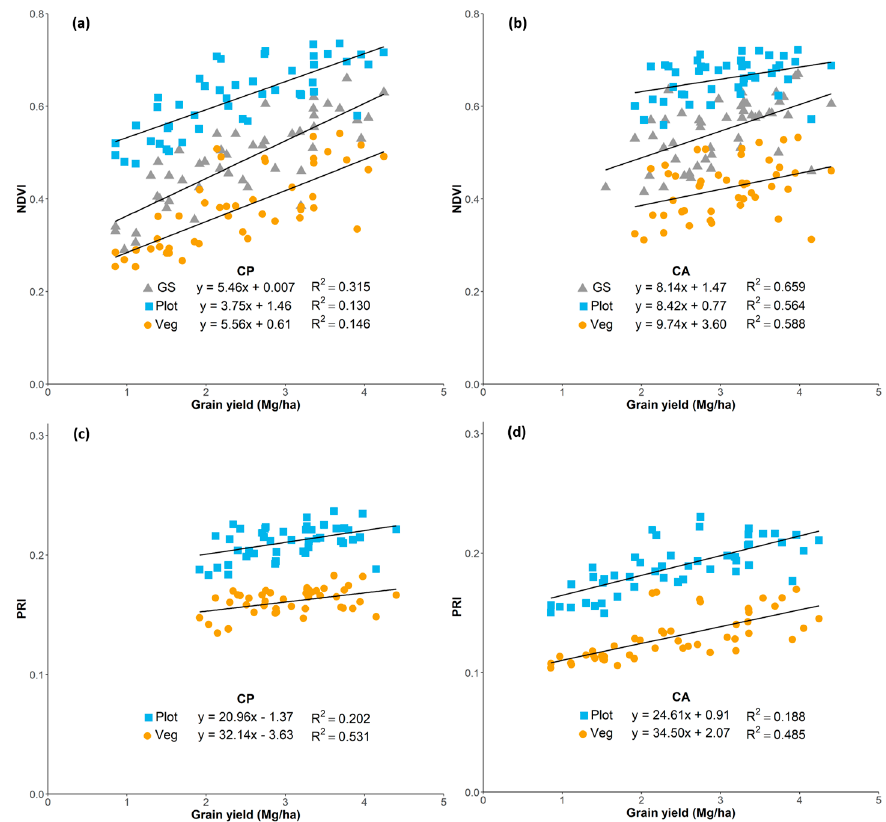
Figure 4. Relationship between grain yield with the Normalized Difference Vegetation Index (NDVI), measured with the GreenSeeker and calculated from the aerial multispectral images ( a , b ) and with the Photochemical Reflectance Index (PRI), measured from the aerial multispectral images ( c , d ).